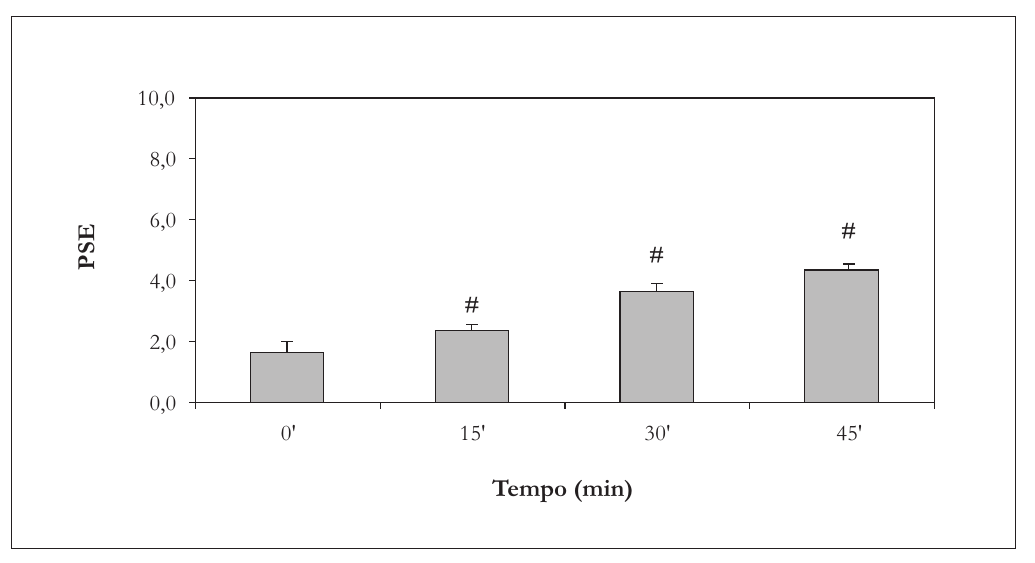
Concentrações plasmática de lactato ([LA])